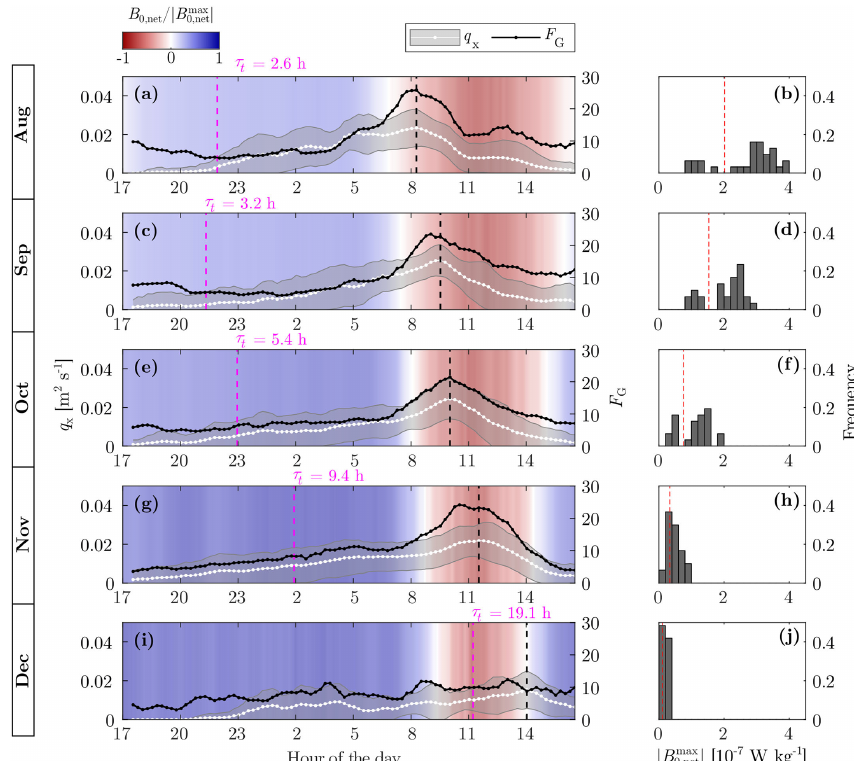
Figure 7. Seasonal variability in the diurnal cycle. (a, c, e, g, i) Monthly average of the diurnal cycle of the unit-width discharge q x and F G parameter. Only days with observed TSs between August and December have been averaged. The shaded white area corresponds to average discharge ± standard deviation. The monthly averaged net buoyancy flux represented as a color map is normalized by the maximum absolute value of each month. The vertical black dashed line indicates the time of maximal q x . The transition timescale τ t defines the starting time of the flushing, represented by a pink vertical dashed line. (b, d, f, h, j) Histograms of the maximum absolute value of the net buoyancy | for each month. The red vertical line corresponds to | B max | of the monthly averaged diurnal cycles. flux | B max 0 , net 0 , net